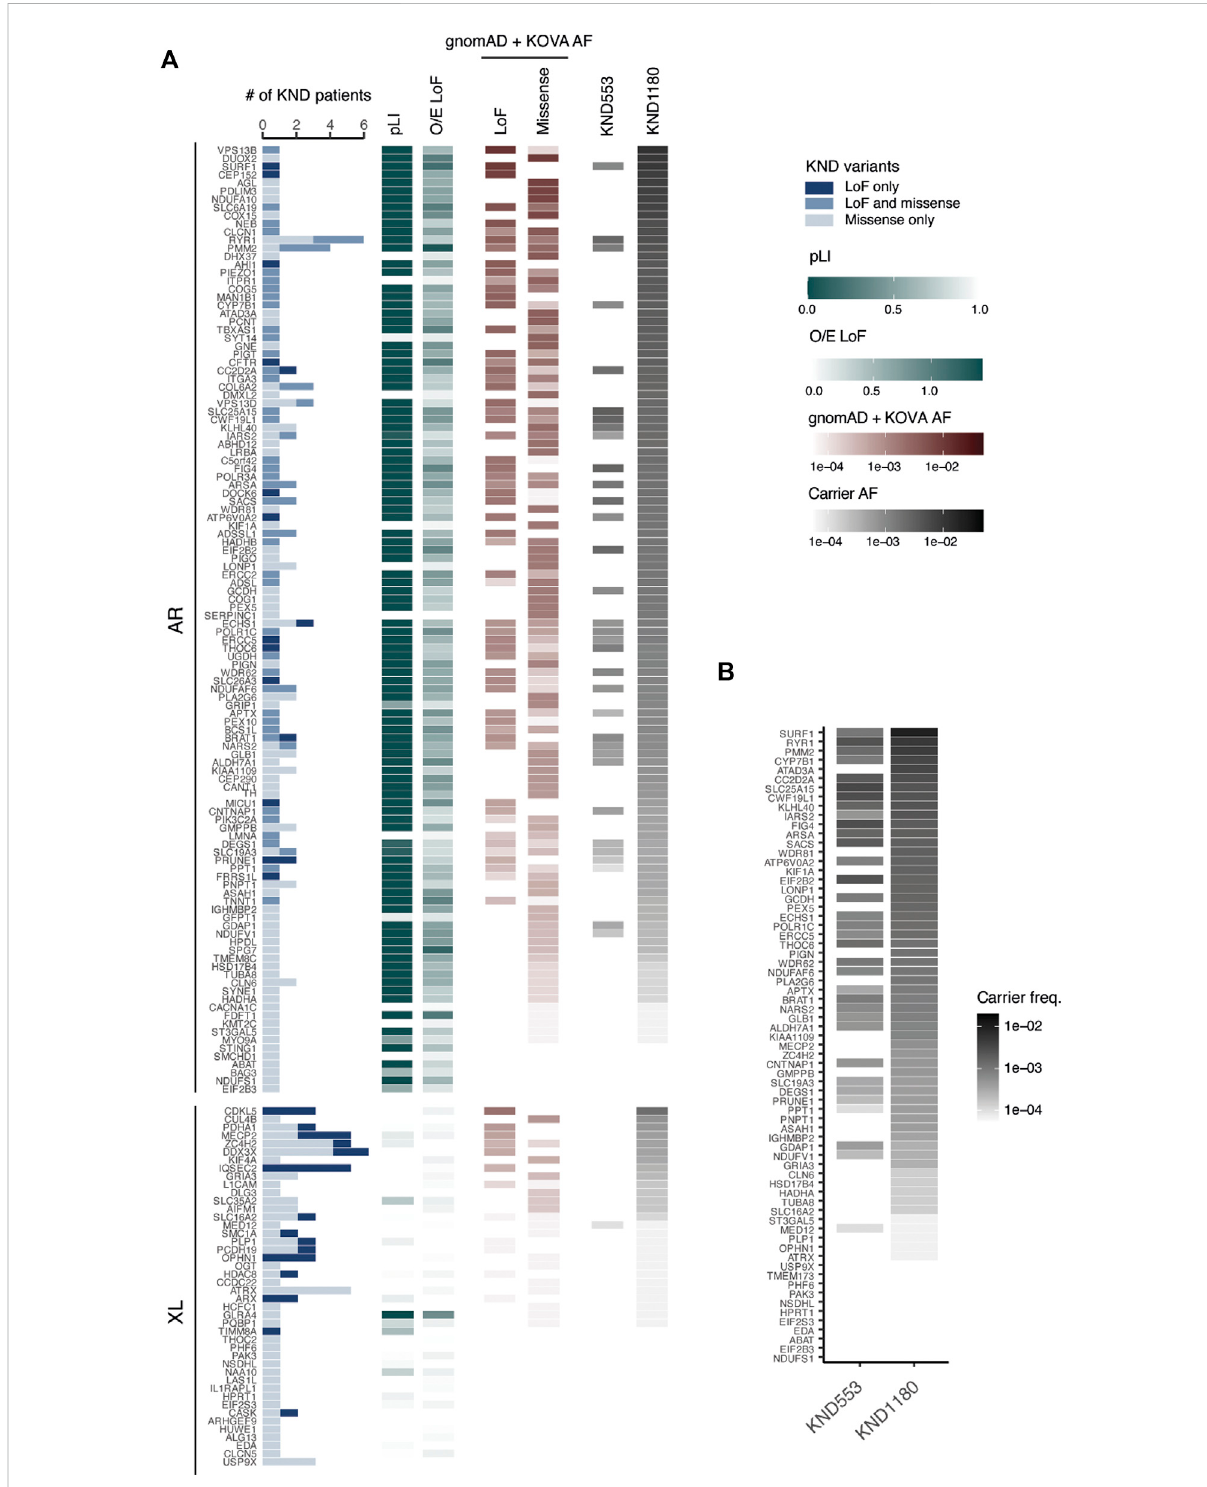
FIGURE 4 Ability to pre-determine NDD carrier status based on KND. (A) Heatmap displaying the number of KND patients carrying a causal variant, pathogenic variant frequency, and ability to predict carrier frequency on 161 genes. (B) Comparison of the ability to predict pathogenic variant carriers based on KND553 or KND1180 on the 34 overlapping